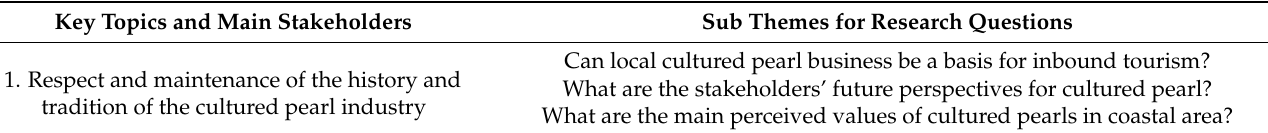
Table 1. Key takeaways from literature